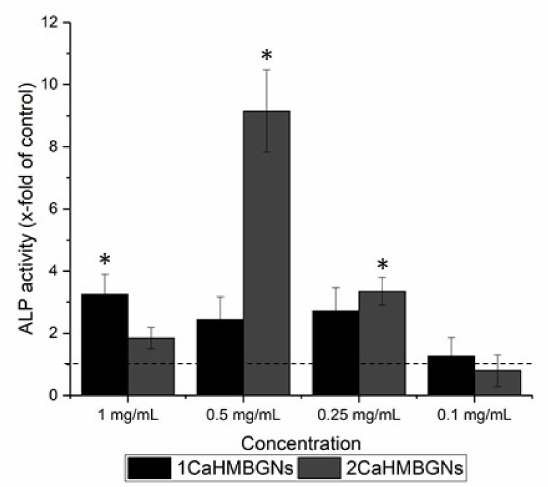
Figure 9. ALP activity of MC3T3-E1 after culture with 1CaHMBGNs and 2CaHMBGNs at different concentrations for 14 days. The ALP activity is presented relative to the control group. Data are presented as mean ± SD and * indicates p <